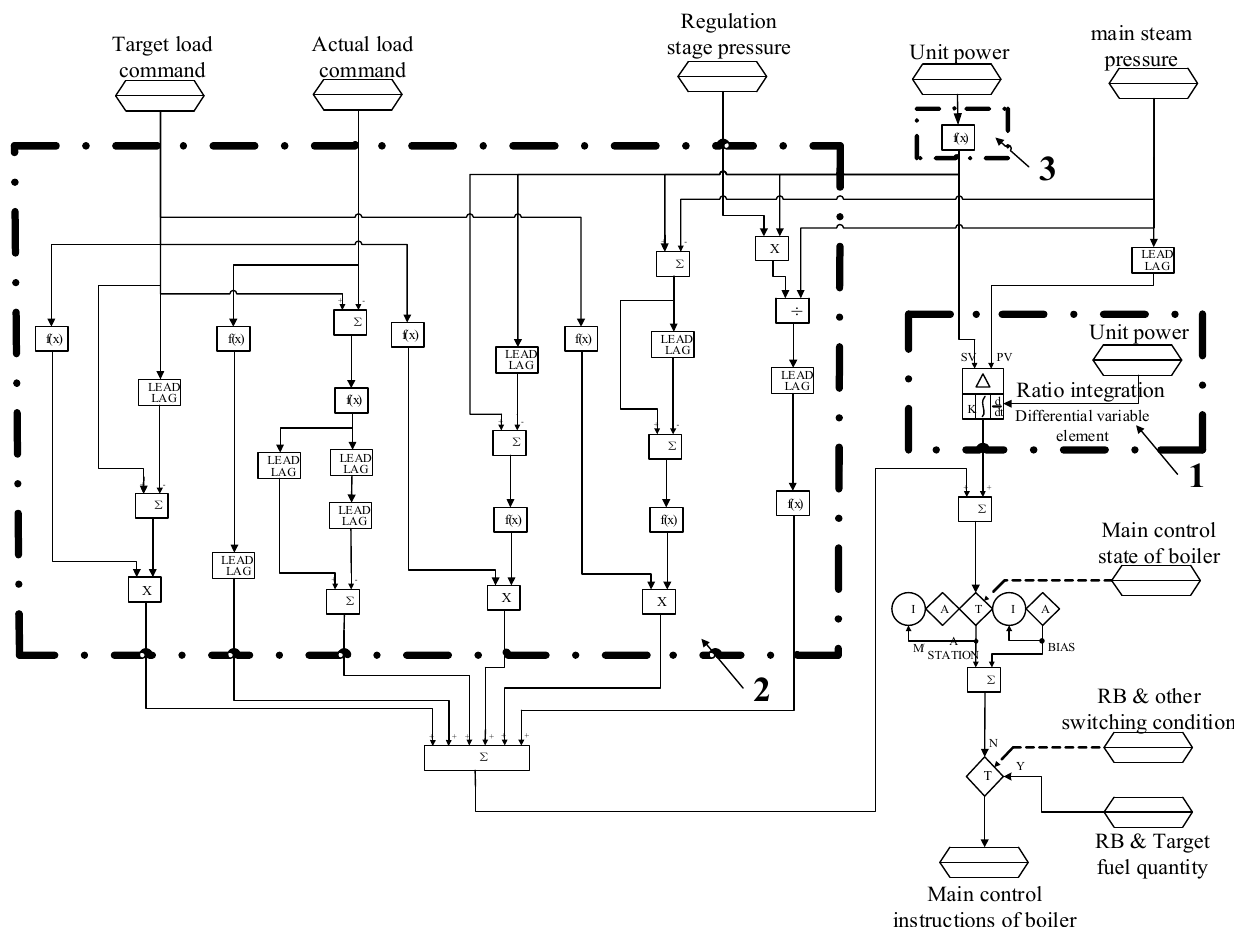
Figure 6. Adjustment block diagram of the boiler main control loop of USC-CFB unit.